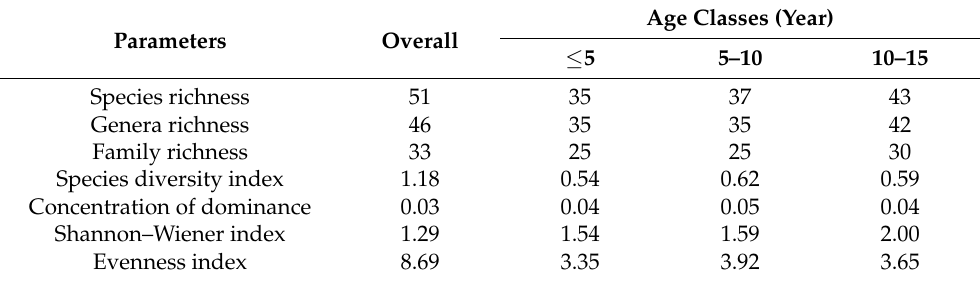
Table 1. Diversity indices of Gmelina farm forestry